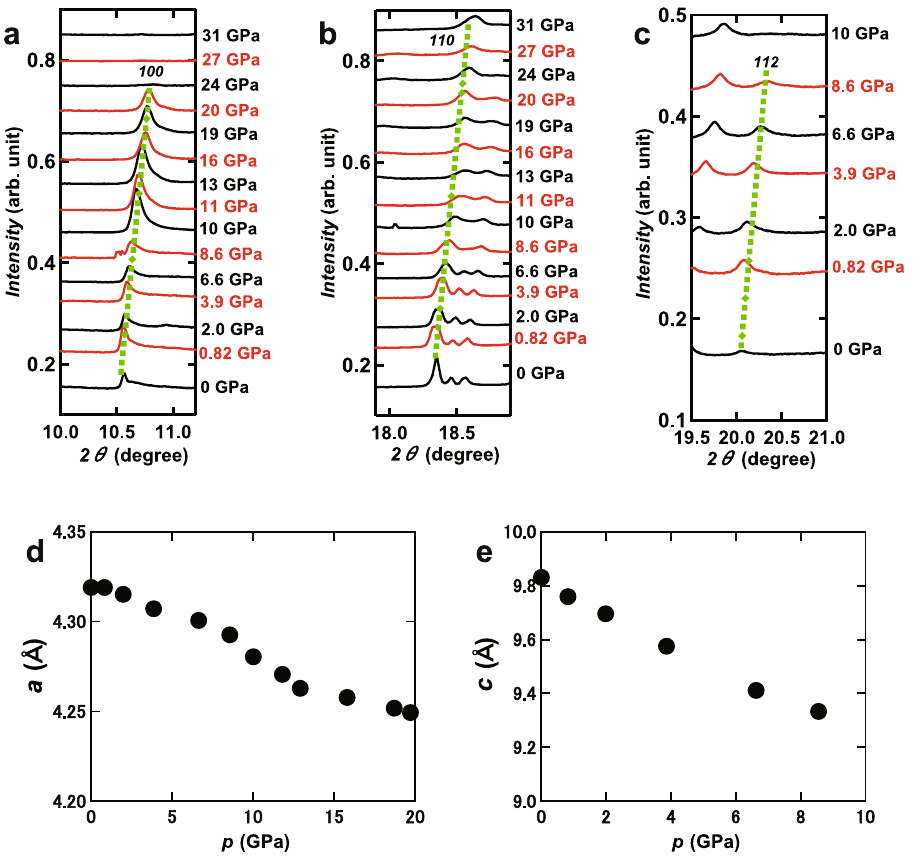
Figure 5. Pressure dependence of peaks ascribable to ( a ) 100 , ( b ) 110 and ( c ) 112 for Ca 0.5(2) Sr 0.5(2) C 6 . ( d ) Pressure dependence of lattice constants, ( d ) a and ( e ) c , for Ca 0.5(2) Sr 0.5(2) C 6